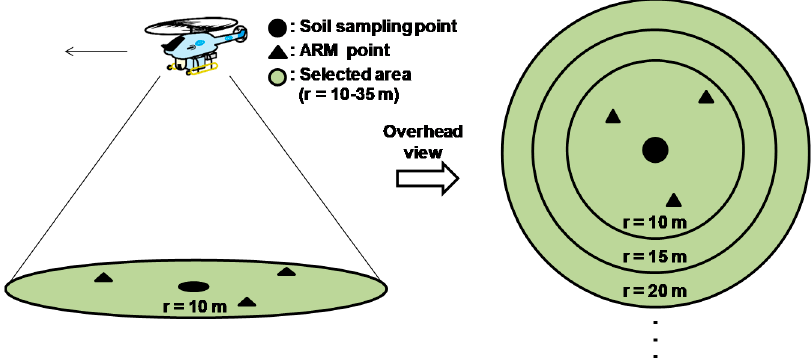
Figure 5. Conceptual schema for ARM data selection based on the position of soil sampling points; black dots indicate soil sampling points, black triangles indicate ARM points, and the green circle indicates the selected area based on the position of soil sampling points.